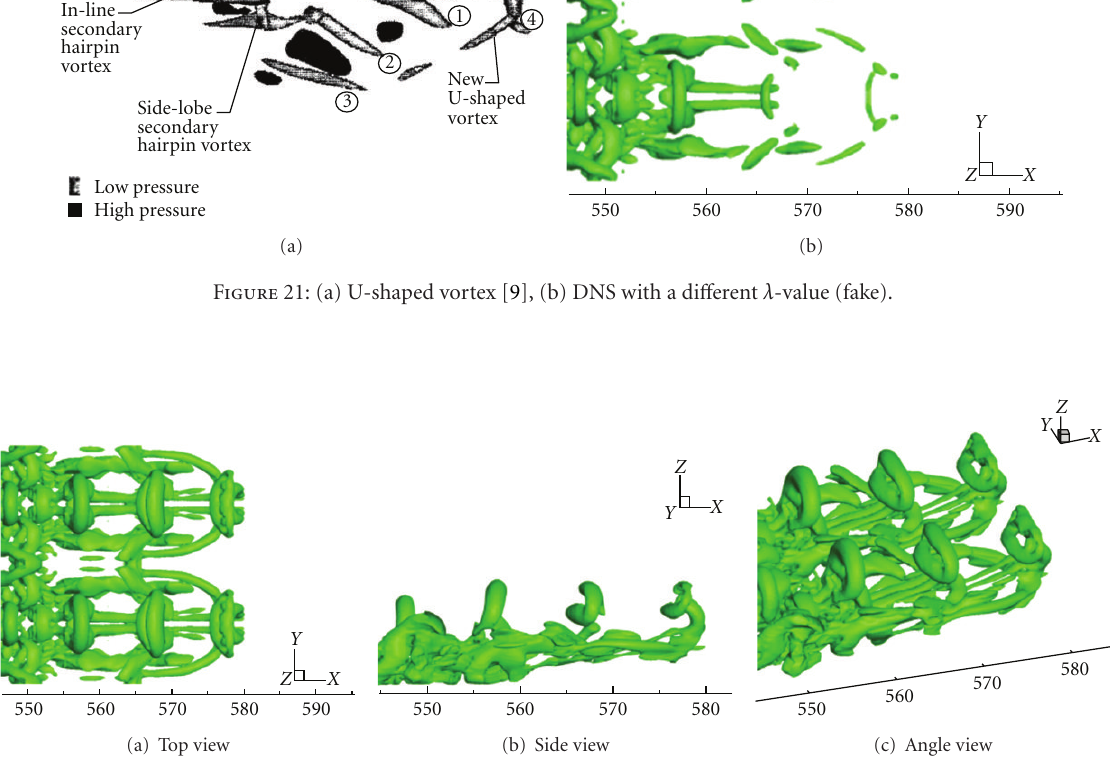
Figure 22: View of young turbulence spot head from di ff erent directions ( t = 8 . 8 T ).